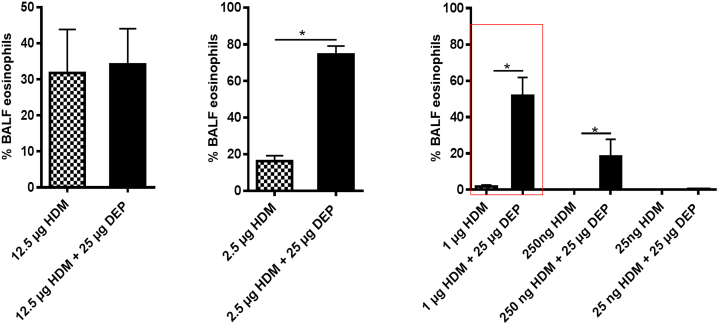
Titration of the HDM dose for the combined DEP+HDM model. C57BL/6 mice were exposed to decreasing doses of only HDM (ie, 12.5 μg, 2.5 μg, 1 μg, 250 ng, and 25 ng of HDM) or the combination 25 μg of DEPs plus decreasing doses of HDM on days 1, 8, and 15. On day 17, BALF eosinophils were determined on cytospin preparations. Data presented on the different graphs represent separate experiments. The red box represents the selected dose for the experiments in the article. Results are expressed as means ± SEMs (n = 8 mice per group). *P < .05.